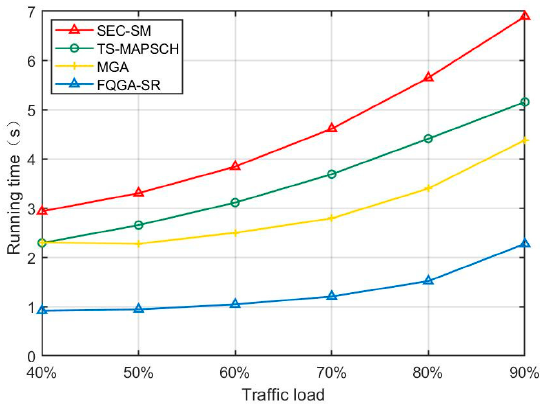
Figure 6. Comparison of algorithm running time.